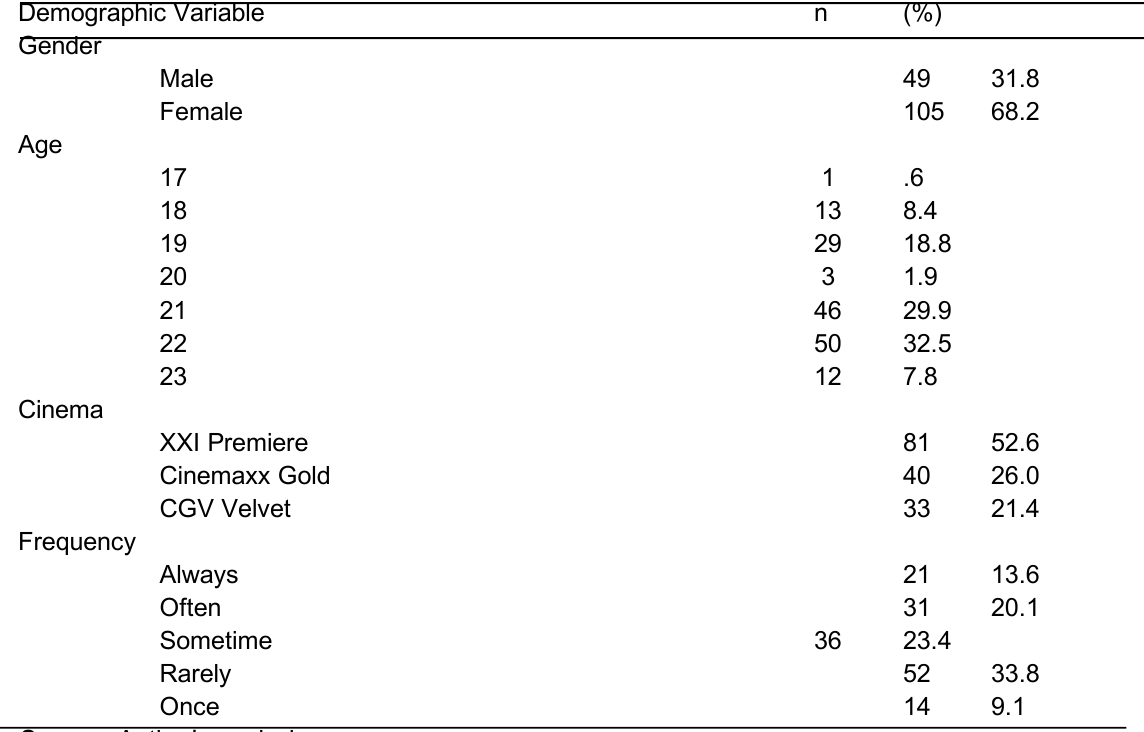
Table 1: Respondents’ Characteristic Based on